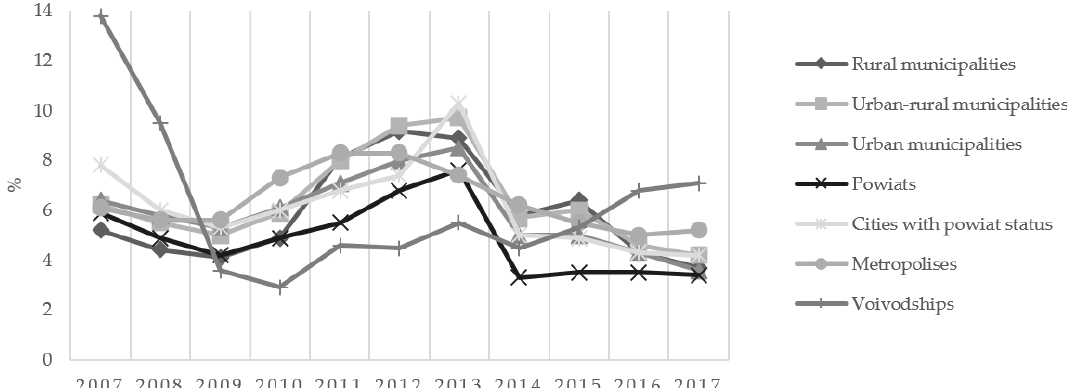
Figure 3. Ratio of debt servicing costs to total income in Polish local government units in 2007–2017 (%). Source: Own calculations based on data from the Ministry of Finance [35].